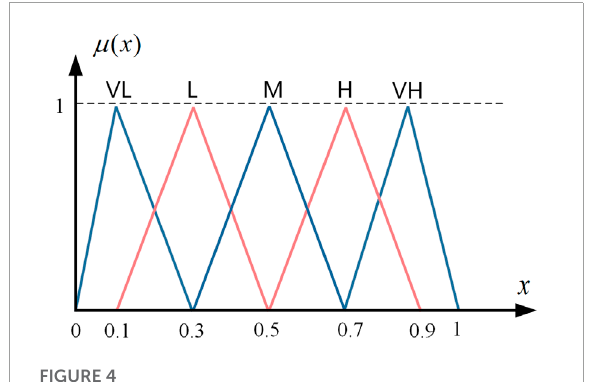
FIGURE 4 Membership functions of TFNs of linguistic variables in Table 2